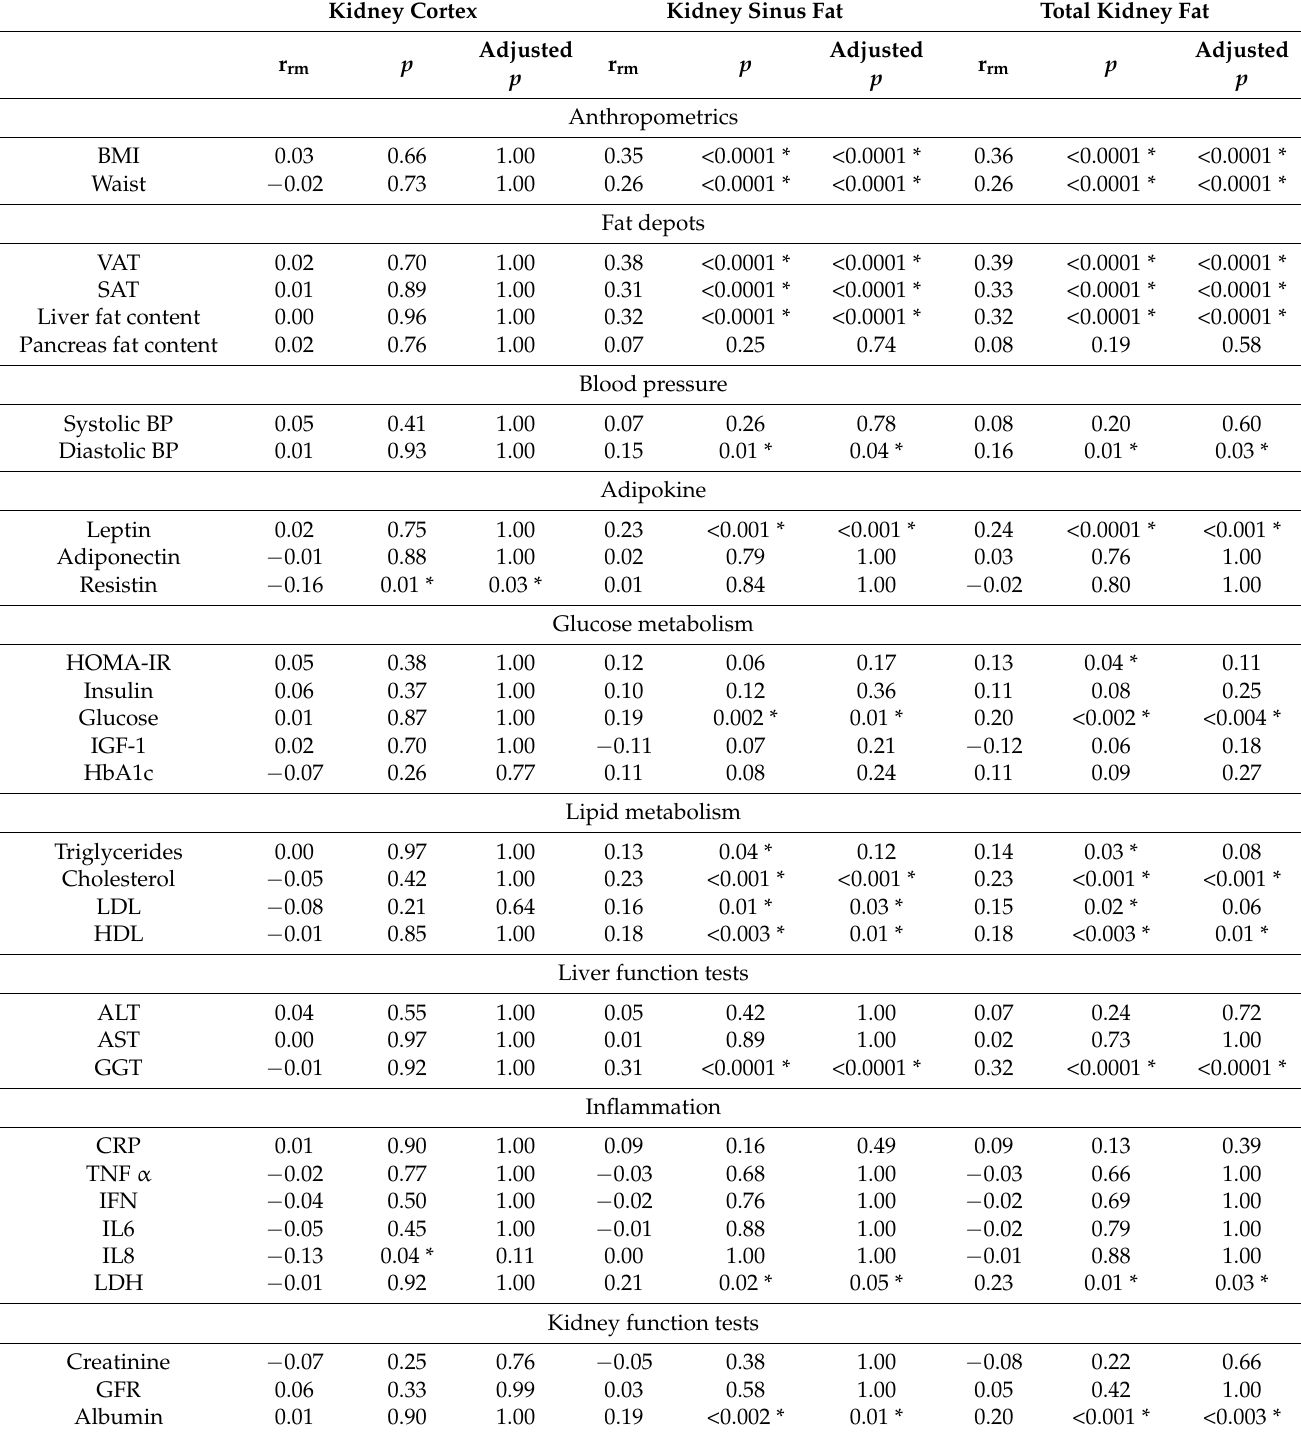
Table 2. Repeated measures correlations of kidney cortex fat, kidney sinus fat and kidney total fat over all time points (time points T0, T1 and T3